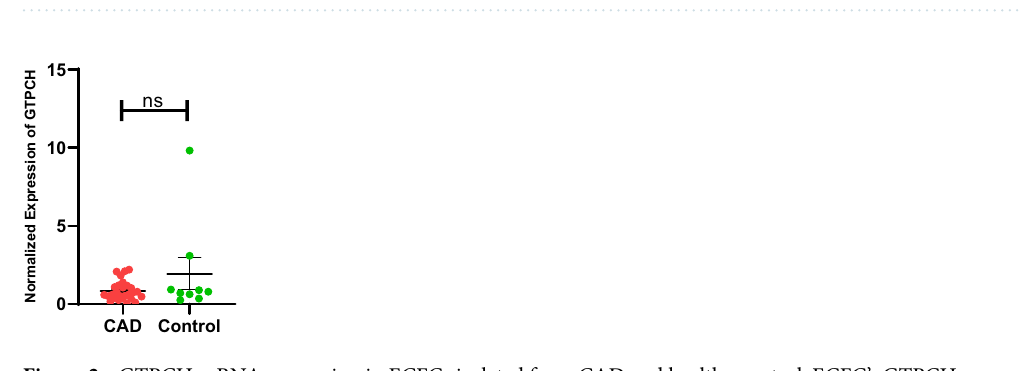
Figure 2. GTPCH mRNA expression in ECFCs isolated from CAD and healthy control. ECFC’s GTPCH mRNA expression level normalized with housekeeping gene β actin in CAD (n = 27) and control (n = 09) groups. Student t-test was used to assess the significance difference. Data is represented as mean ± SE. Error bar represent standard error of mean; dots represent average values of the parameters obtained from experimental triplicates. p ≤ 0.05 considered statistically